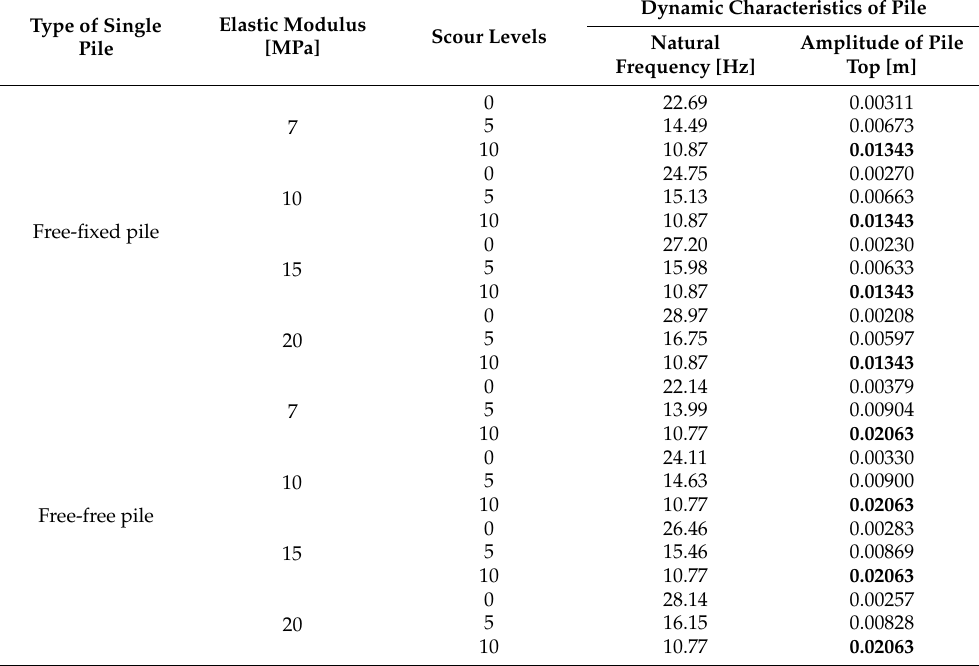
Table 5. Effect of the elastic modulus of soil on dynamic characteristics of the single pile under varied scour